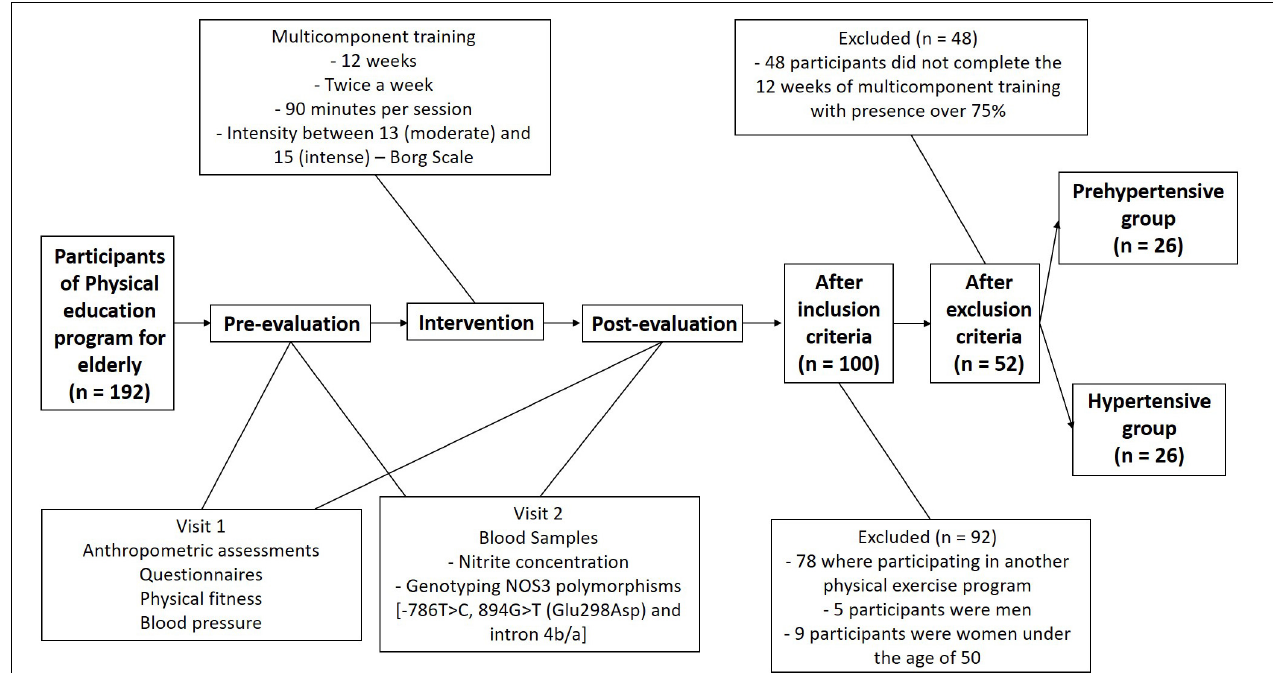
FIGURE 1 | Flow chart – study design and sample